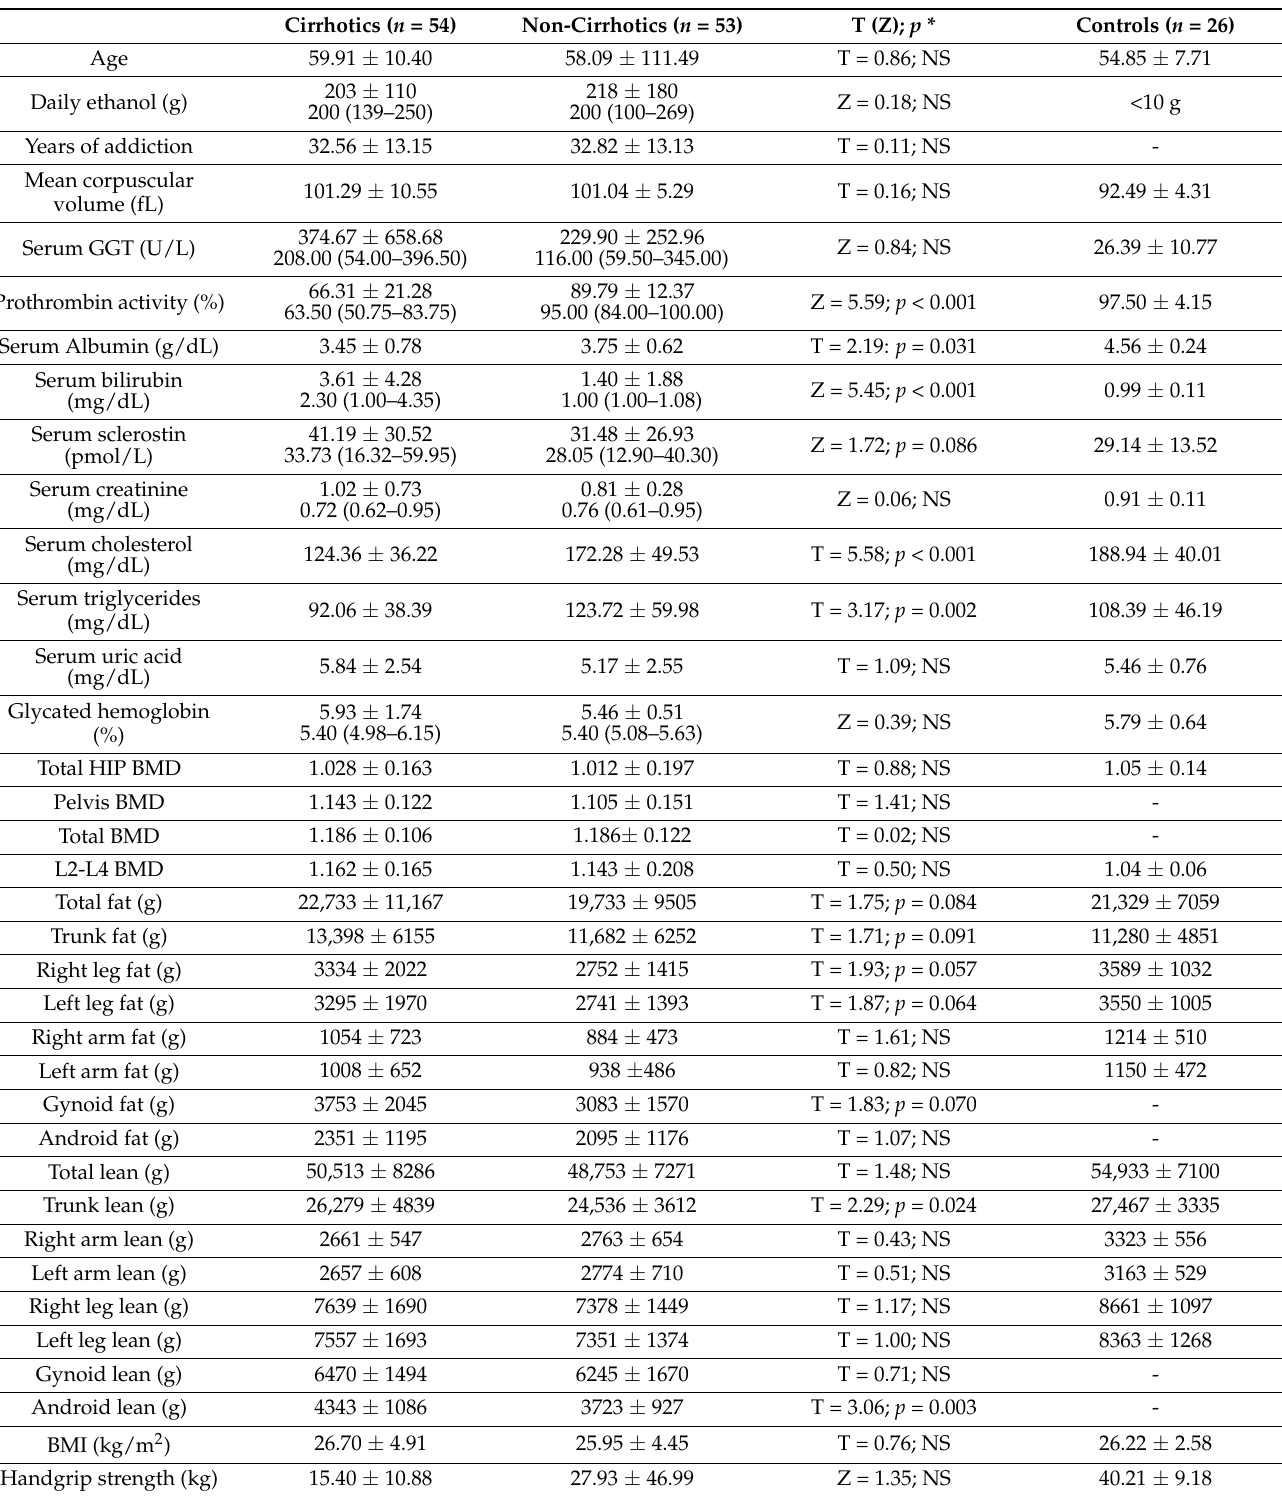
Table 1. Some biological features of cirrhotics and